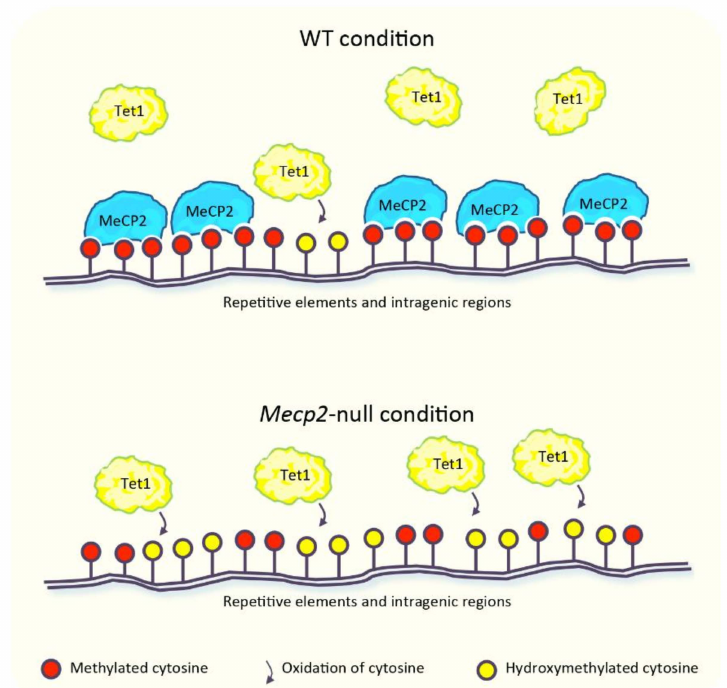
Figure 1. MeCP2 protects DNA methylation from oxidation. In physiological conditions, MeCP2 competes with Tet1 for the binding of methylated cytosines across repetitive elements and intragenic regions ( top ). The absence of MeCP2 opens the access to Tet1, which converts 5-methylcytosines to 5-hydroxymethylcytosines, leading to an enhanced hydroxymethylation ( bottom ) [76,77].